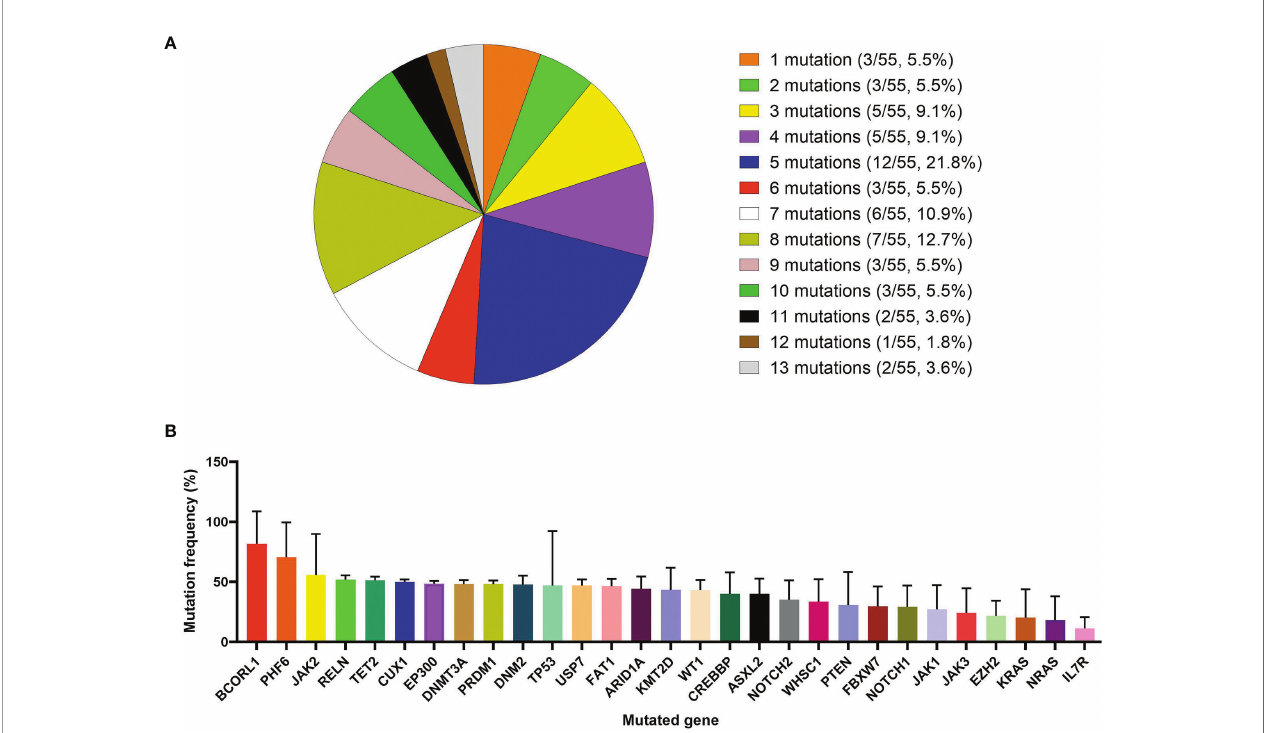
FIGURE 5 | Detection of 112 types of hematological tumor-related gene mutations in 55 T-ALL children. (A) Detection of gene mutations in 55 T-ALL children with targeted next-generation sequencing (NGS) method. (B) Distribution of mutation frequency of genes with mutations detected three times or